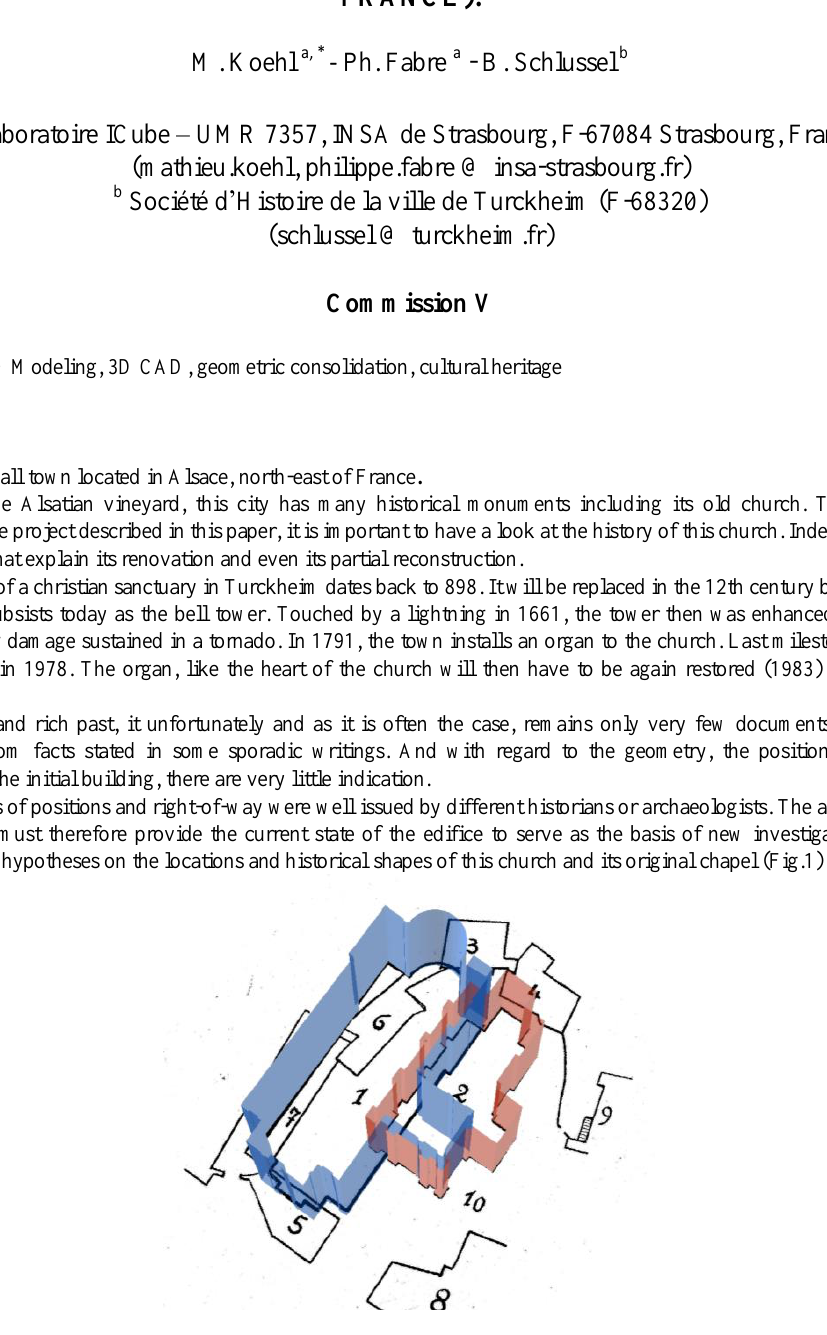
Fig.1: Hypothetic localization of chapel (2) vs actual church